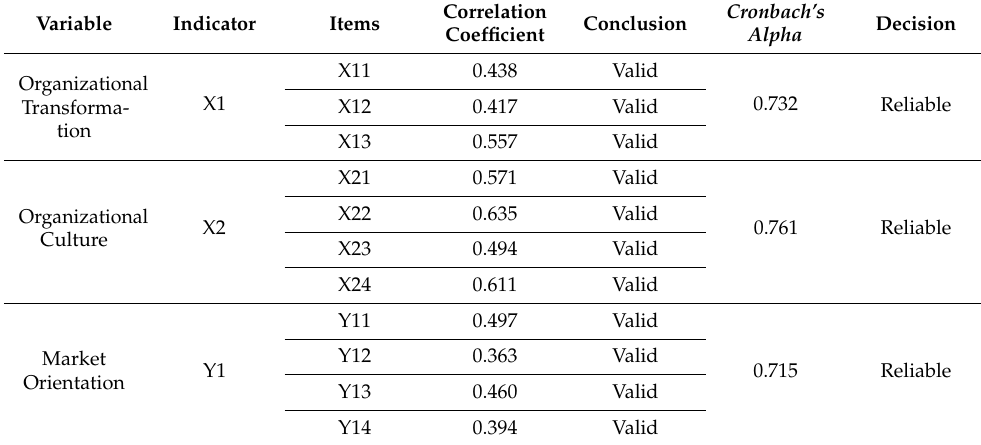
Table 1. Validity and Reliability Test Results.